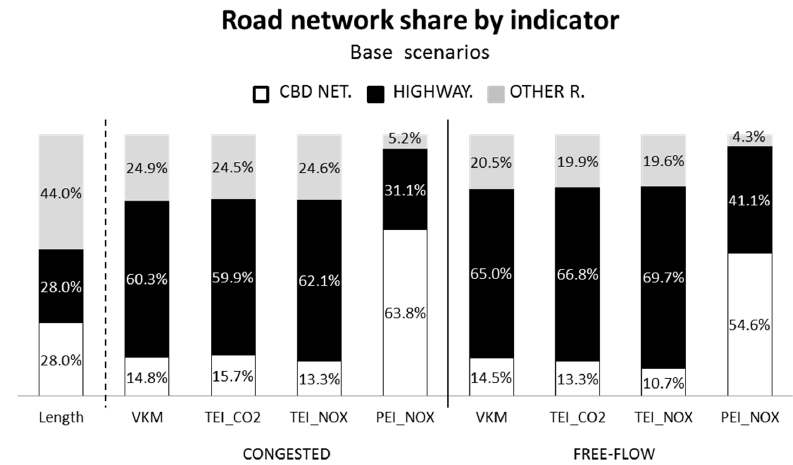
Figure 4. Indicators’ share of the total road network by road type in the base congested and